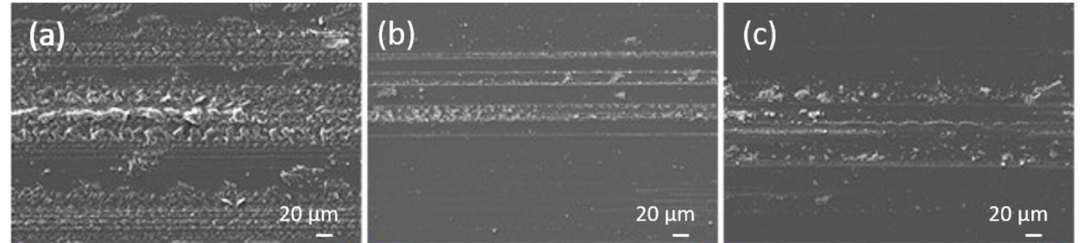
Figure 3. Wear tracks for epoxy coating; ( a ) dry sliding, ( b ) sliding in water and ( c ) sliding in Hank’s